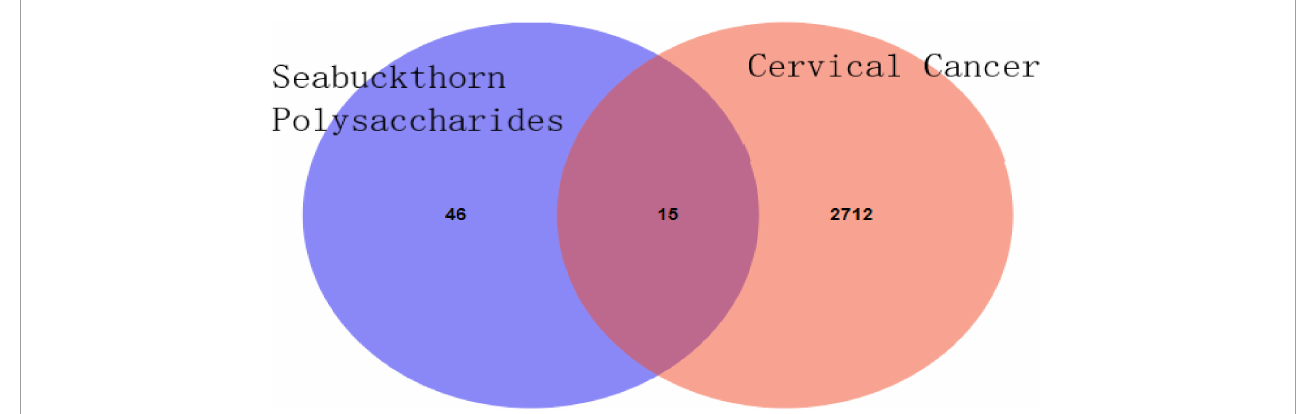
FIGURE1 Venn diagram of seabuckthorn polysaccharides and cervical cancer targets.